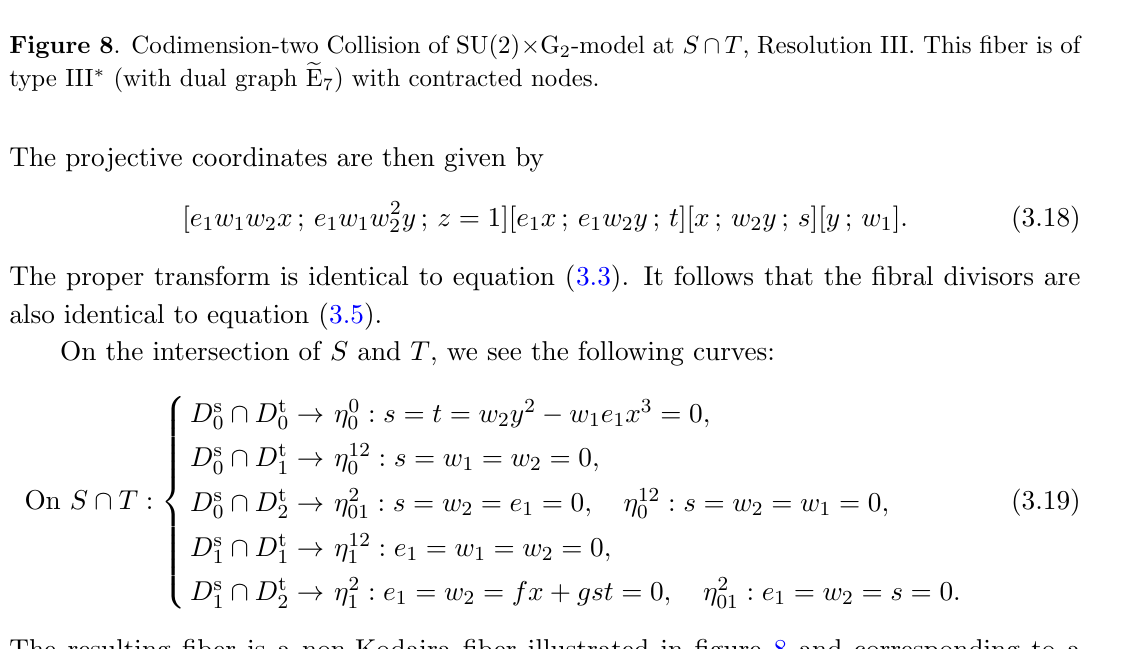
\ T , Resolution III. This (cid:12)ber is of 2 -model at S